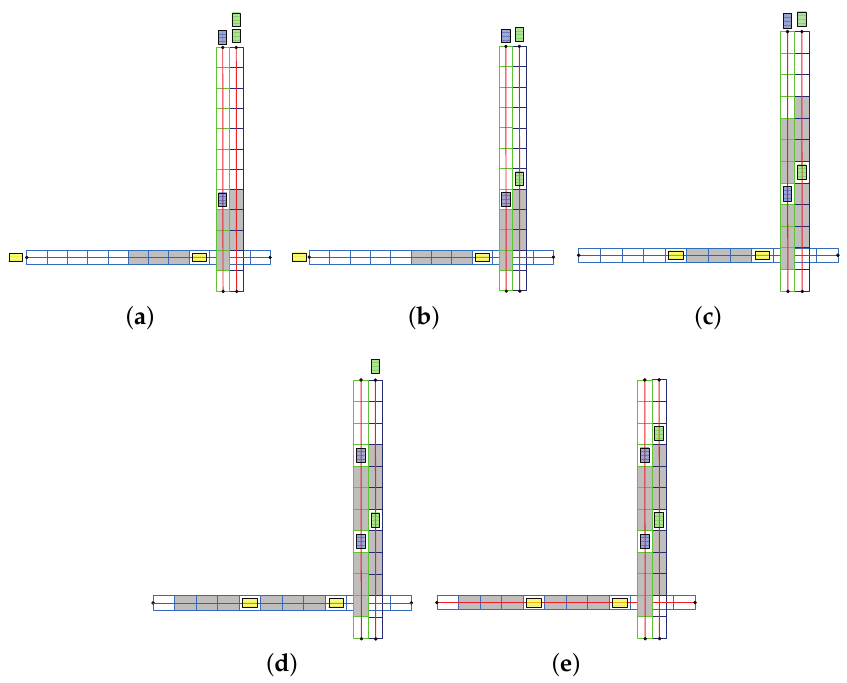
Figure 15. Steps 2–6, ( a ) step 2, ( b ) step 3, ( c ) step 4, ( d ) step 5, ( e ) step